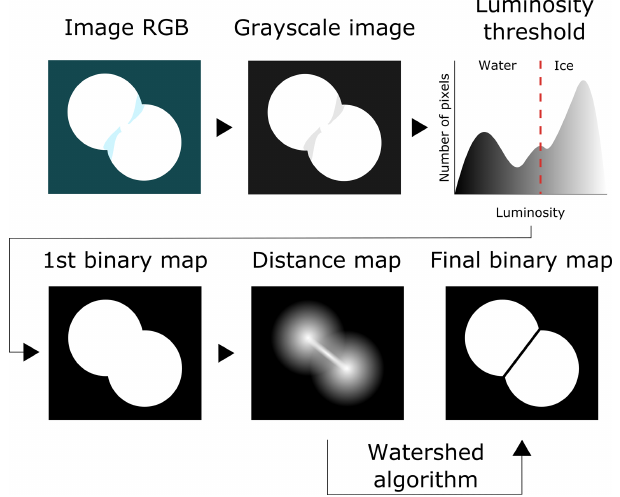
Figure 3. Steps of the image processing algorithm used for the boundary identification of floes in the GSL experiment.